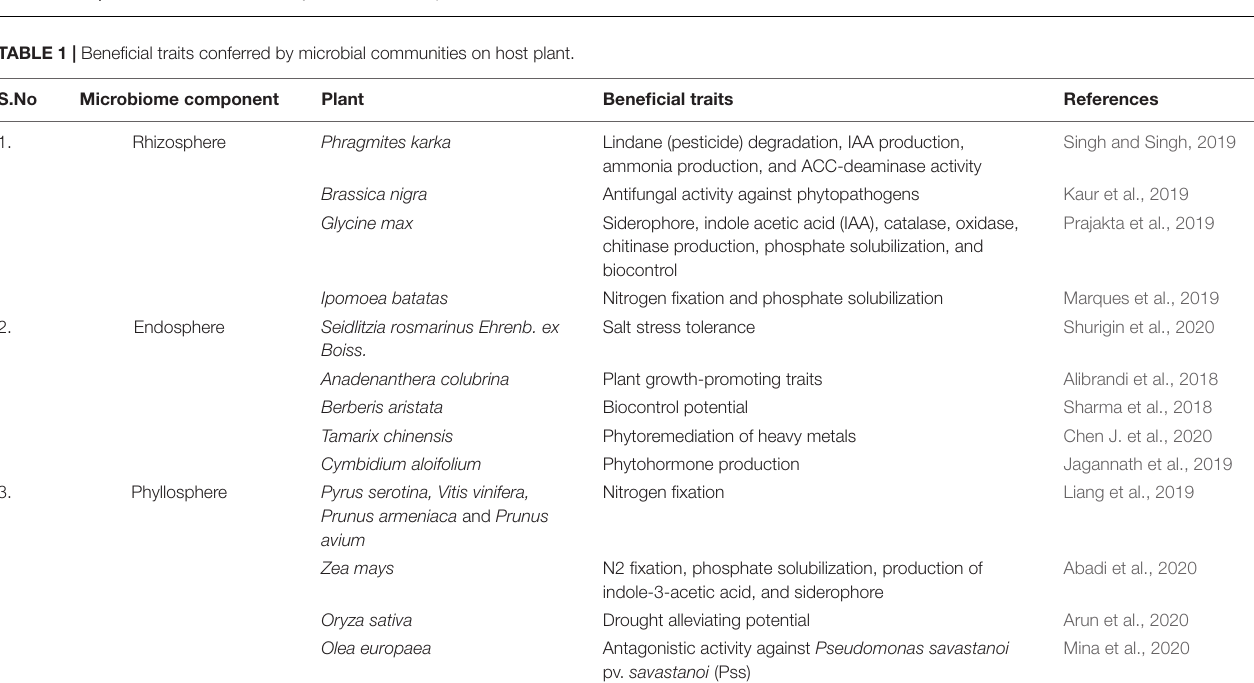
FIGURE 1 | The three main microecosystem involved in plant-microbe interactions.